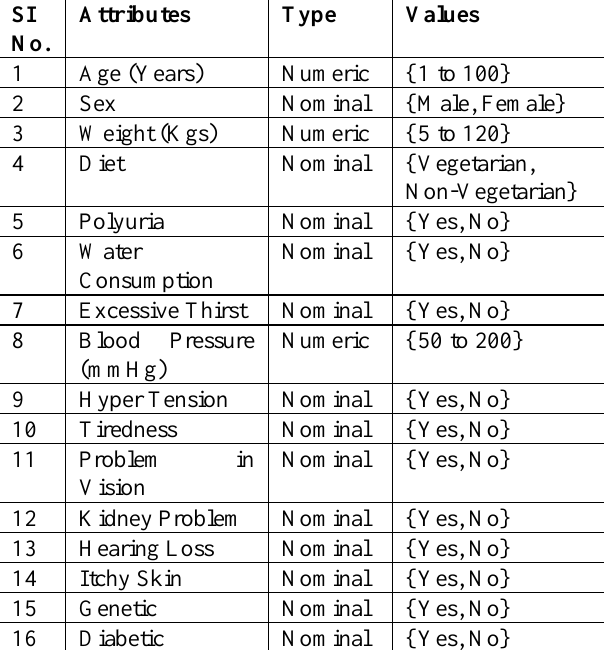
Table 7.Dataset Description